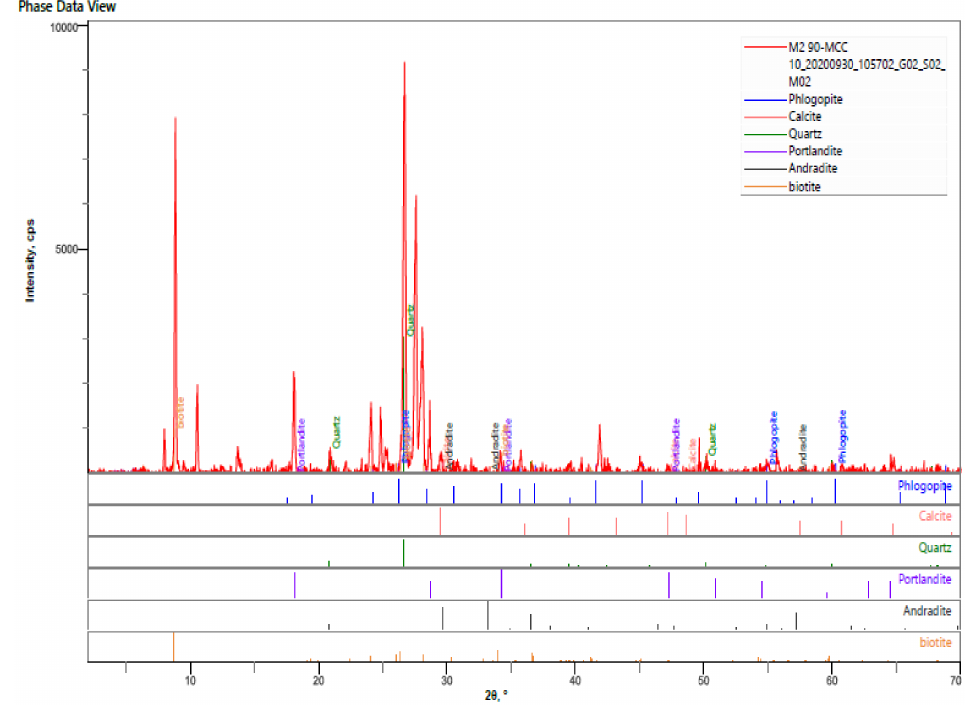
Figure 17. XRD pattern of the hardened MCCC-10 sample at 90